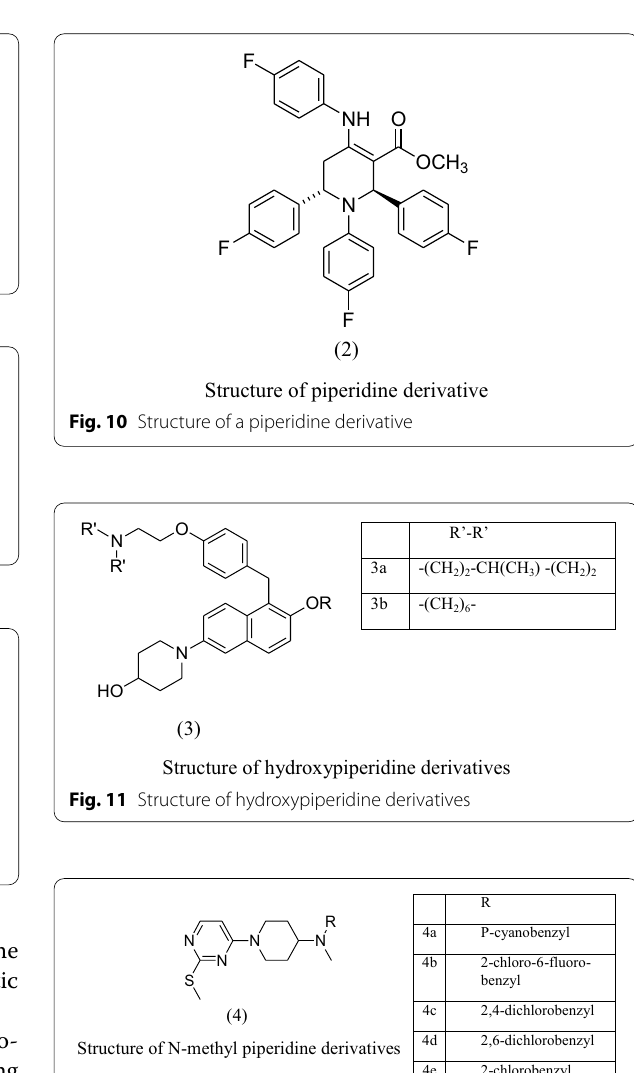
Fig. 12 Structure of N‑methyl piperidine